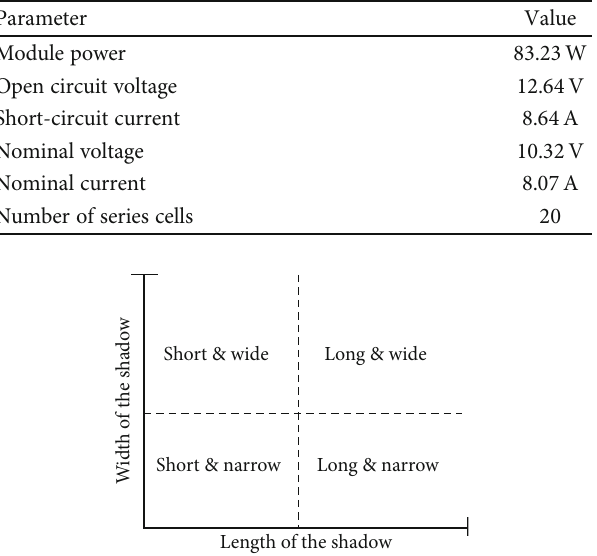
Figure 9: Various types of shading shape [29].